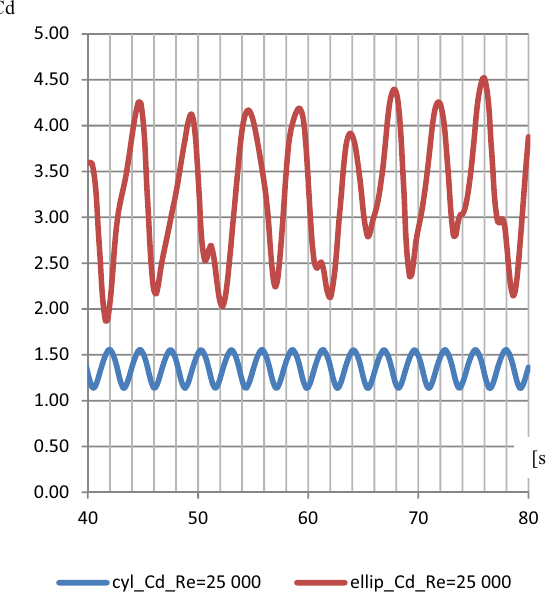
Fig.12 Dependence of vorticity magnitude for circle and ellipse sections, Re=25 000 on angle describing the analysed point on